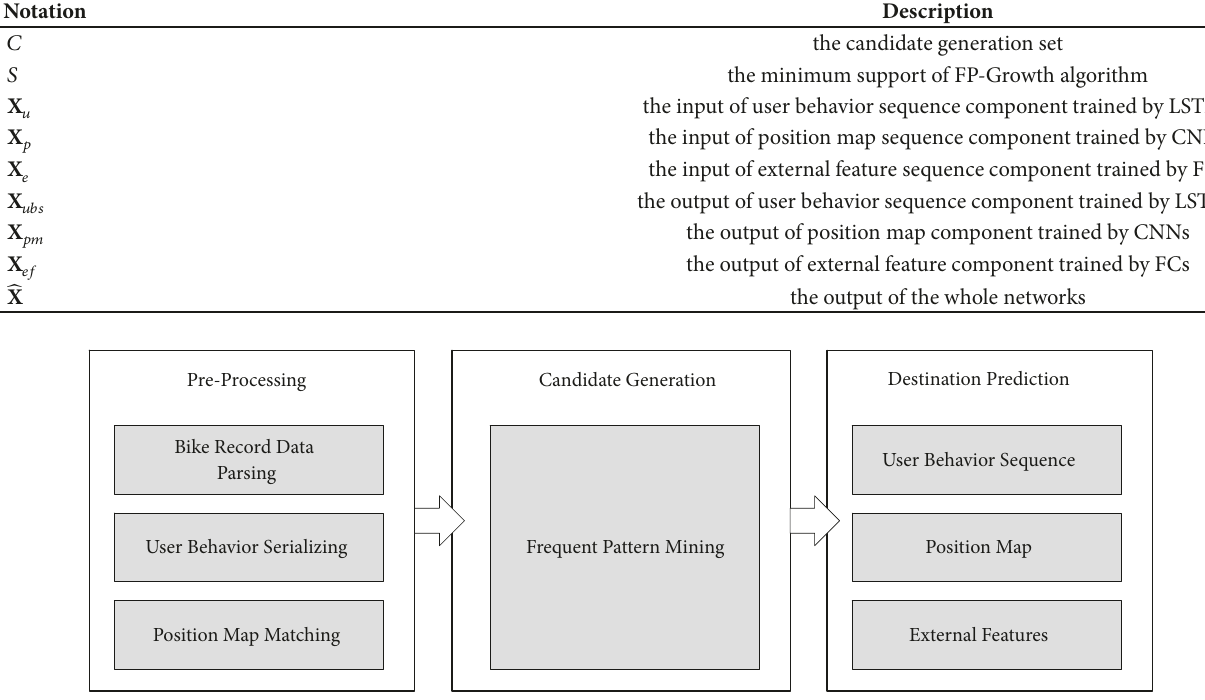
Figure 3: An overview of the